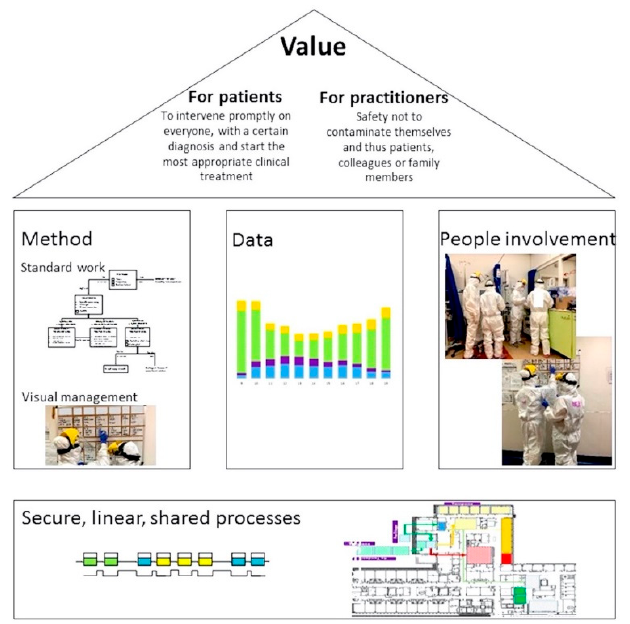
Figure 3. Lean approach to Covid-19 pandemic in the Emergency Department.